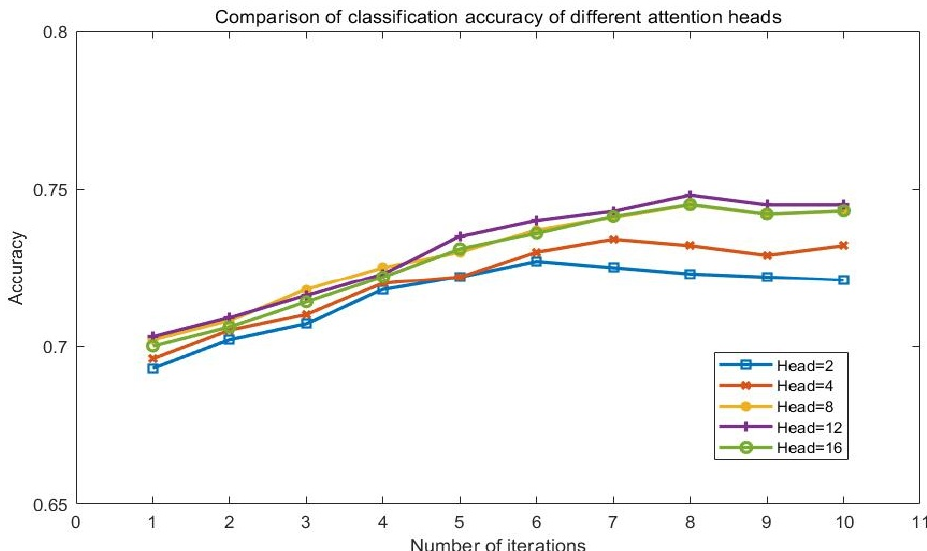
Figure 8. Comparison of accuracy of different attention heads.